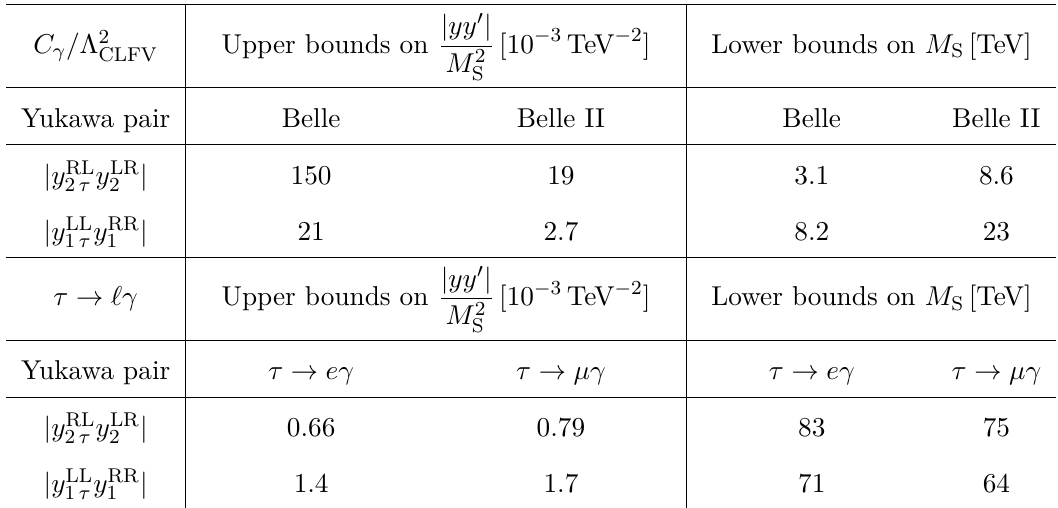
and S 1 / 3 single-scalar-leptoquark cases (only one 2 1